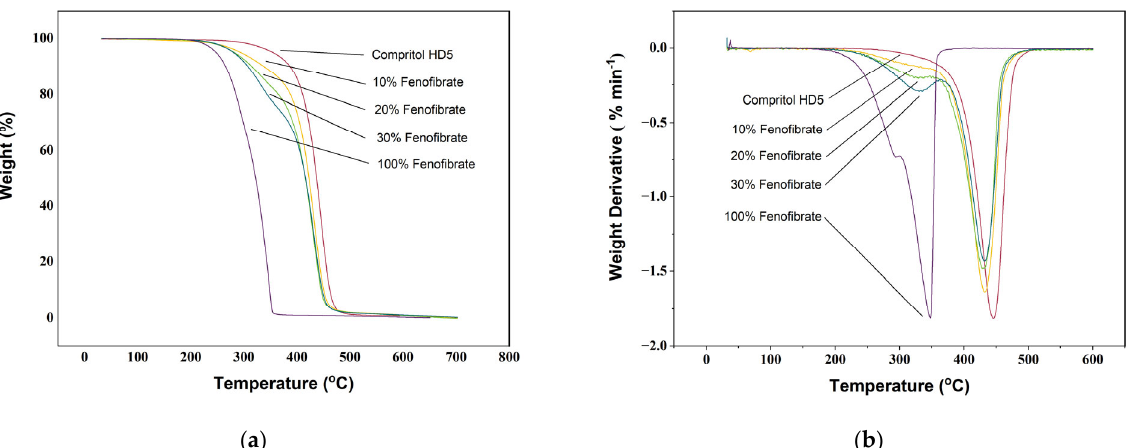
Figure 2. Thermogravimetric curves ( a ) and their derivatives ( b ) of pure Fenofibrate, Compritol HD5 ATO and mixture of the two at 5% ( w / w ), 10% ( w / w ), 20% ( w / w ) and 30% ( w / w ).